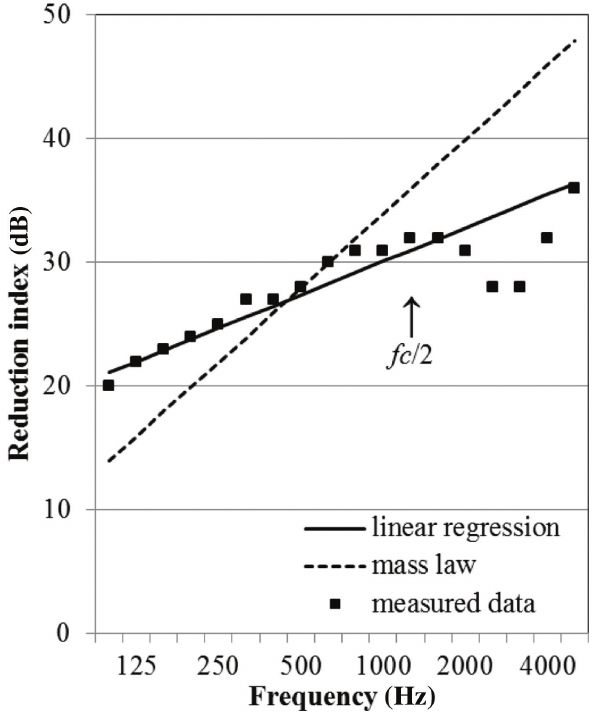
Reduction index of a sliding window. The solid line represents the result of the regression analysis. The dashed line represents values using the mass law.